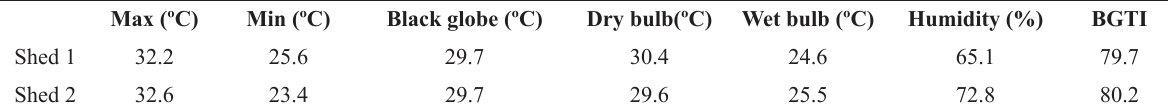
Mean values for maximum, minimum, black-globe, dry-bulb, and wet-bulb temperatures, relative humidity, and Black Globe Temperature and Humidity Index (BGTI) in the period from 22 to 42 days